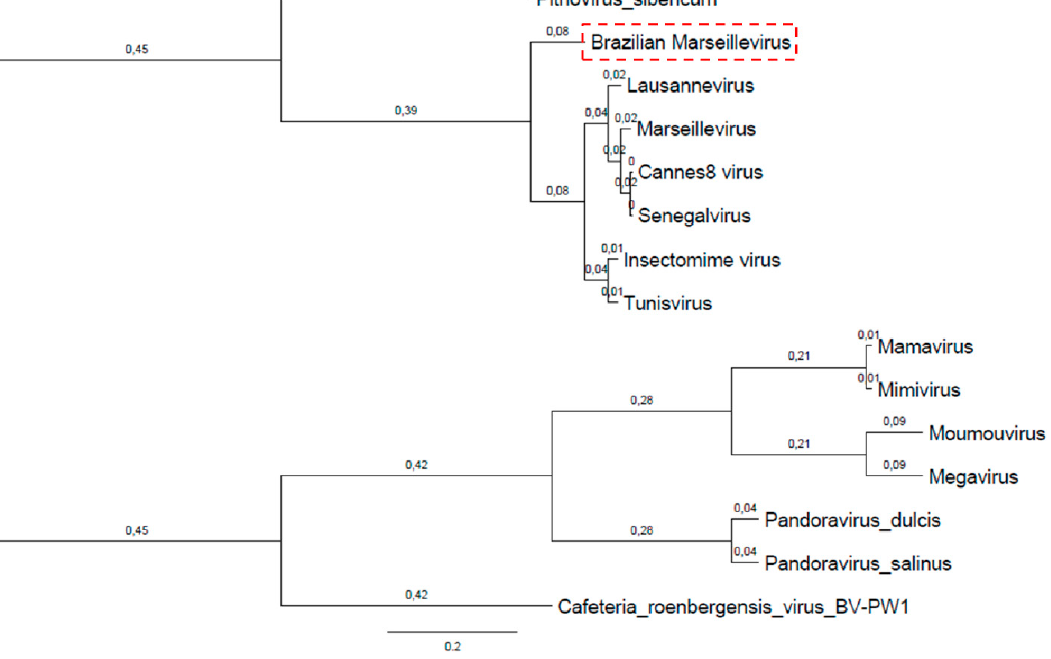
Figure 6. Phylogenetic reconstruction based on a concatenated alignment of the five core genes, DNA polymerase B, major capsid protein, VV-A18 helicase, D6/D11 helicase and D5 helicase. The amino acid sequences were aligned using Muscle and the tree was built using FastTree. Pithovirus sibericum was used as an outgroup. Branches delineating the different lineages of the family Marseilleviridae are colored (dark blue for lineage A, purple for lineage B, blue for lineage C and red for lineage D).